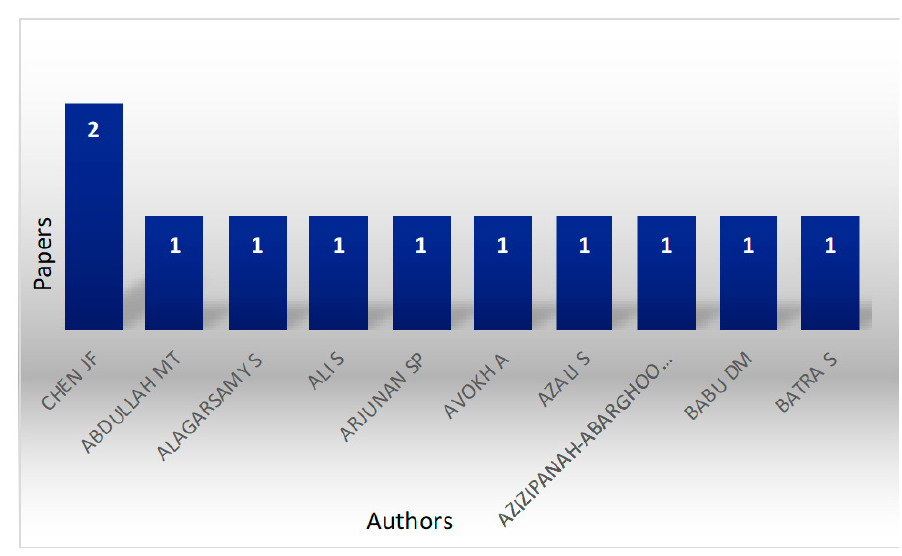
Figure 15. Record by authors for topic: Optimization fuzzy clustering with cuckoo search algorithm.